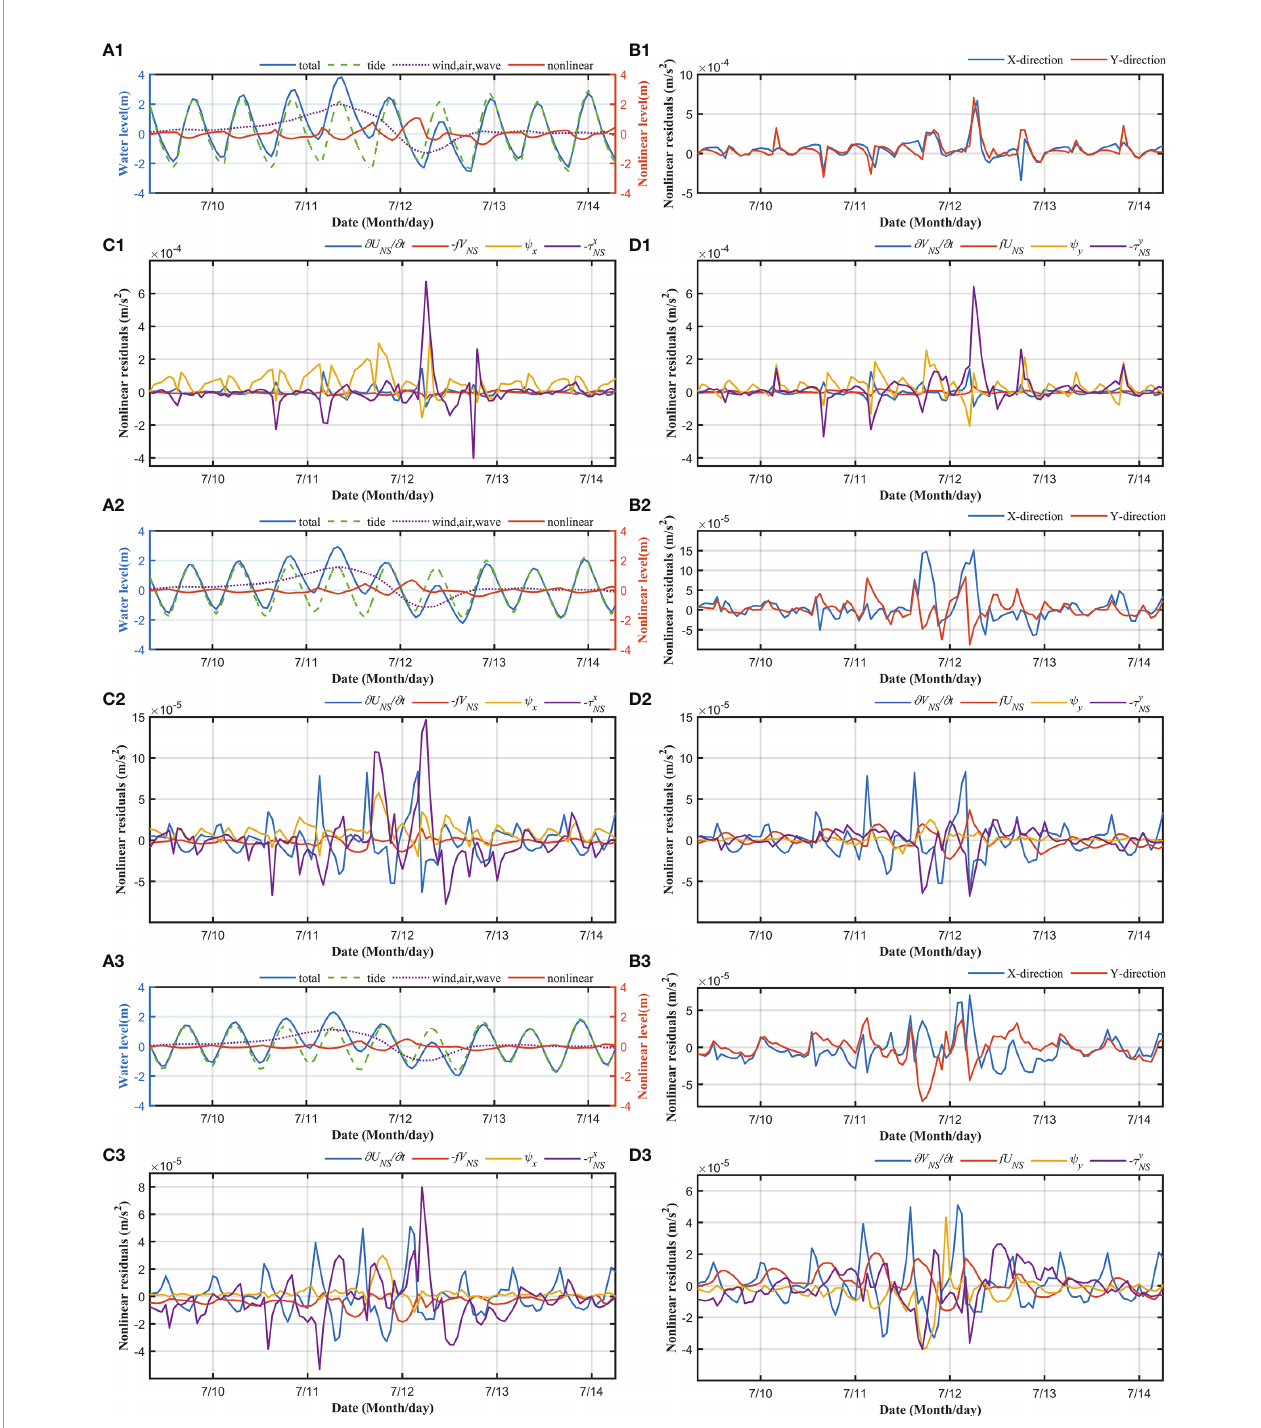
FIGURE 9 | At station P1: (A1) Sea surface levels and surges in different cases. (B1) Sum of nonlinear surges in the x and y directions. Nonlinear components in the (C1) x direction and (D1) y direction. (A2 – D2) and (A3 – D3) are same as (A1 – D1) , but for station P2 and P3,